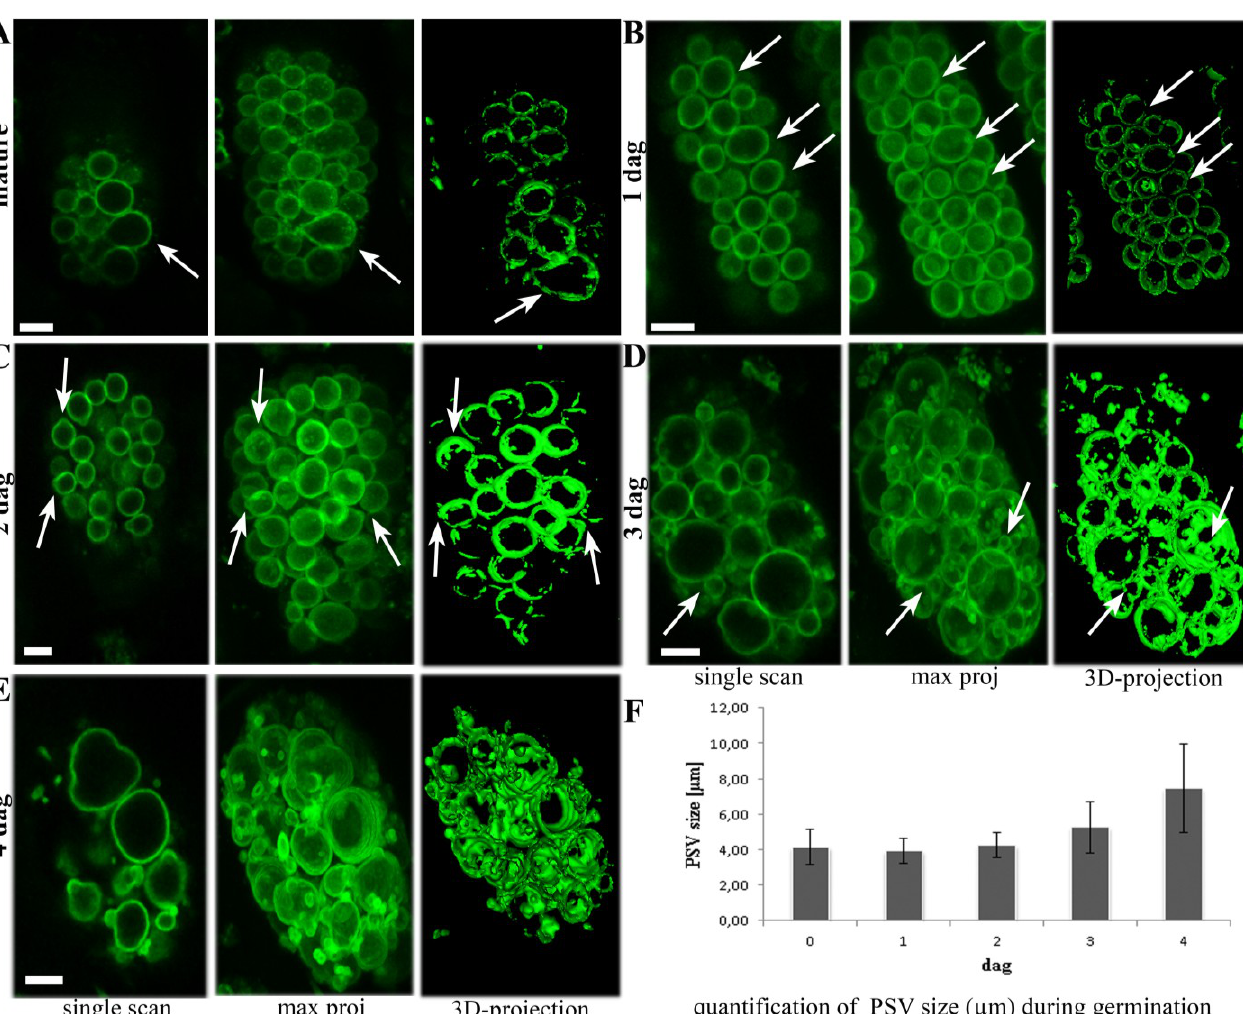
Figure 1. The dynamic morphology of tonoplast intrinsic proteins (TIP)3-GFP-labelled protein storage vacuoles (PSVs) during 4 days of germination. ( A ) TIP3-GFP labels spherical PSVs in the aleurone layer of mature kernels, plus occasional ellipsoid PSVs (arrows); ( B ) Homogeneous and tightly packed PSVs after one day of germination; ( C ) Arrows indicate PSVs starting to form buds at 2 days after germination; ( D , E ) PSVs become larger and more heterogeneous, with spherical, ellipsoid, small and large structures. Arrows indicate that small PSVs are still connected to large ones. Scale bar = 5 µm. ( F ) The average PSV size in µm during 4 days of germination. Standard error bars are indicated (n =